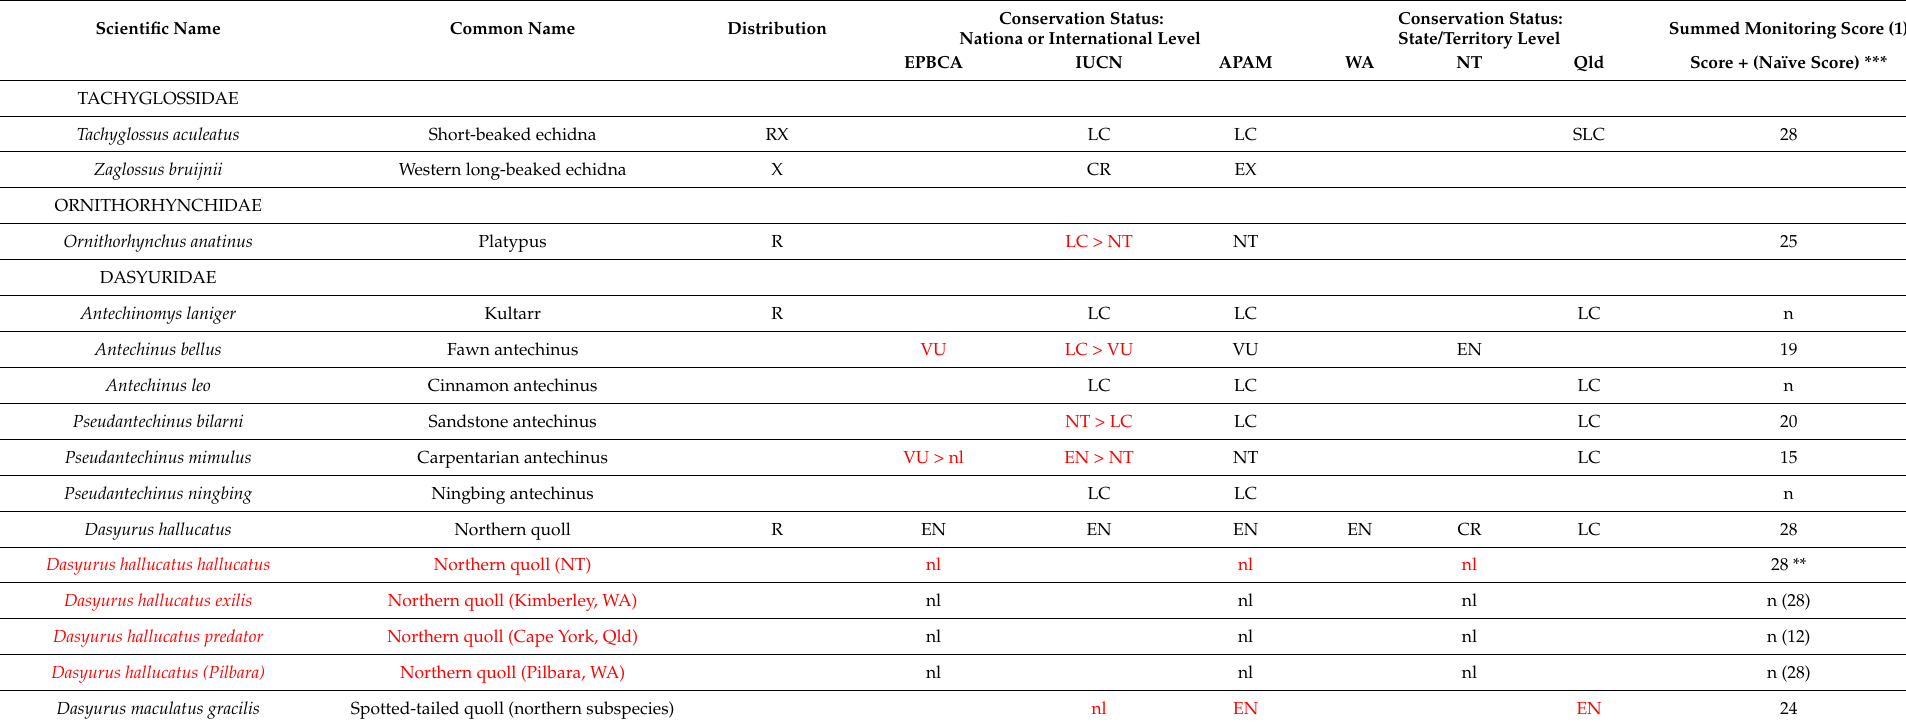
Table 1. List of mammal species occurring in northern Australia at the time of European settlement (updated from Ziembicki et al. 2015) [23]. Note that this excludes the Wet Tropics area of northeastern Australia. Distribution (at the time of European settlement) is in addition to northern Australia: R = other parts of Australia; X = extralimital. Conservation status is given as for Australian national legislation ( Environment Protection and Biodiversity Conservation Act 1999 ; EPBCA), the IUCN Red List, and as assessed in the Action Plan for Australian Mammals 2012 (APAM) [51]. Conservation status categories: EX: extinct, EXW: extinct in the wild, CR(PE): critically endangered (possibly extinct), CR: critically endangered, EN: endangered, VU: vulnerable, NT (CD): near threatened (conservation dependent), NT: near threatened, LC: least concern, and DD: data deficient. Note that EPBCA and APAM status refer to Australian range only. Changes since the original table are highlighted in red font, with an arrow (>) to indicate changes; nl = not listed; ‘n’ = not listed as monitored (Woinarski et al. 2018b) [19]; for conservation status at the state/territory level, WA refers to listing in the Western Australian Biodiversity Conservation Regulations 2018 , NT to listing in the Northern Territory’s Territory Parks and Wildlife Conservation Act 1976, and Qld to listing in Queensland’s Nature Conservation Act 1992 . (1) [19]—max score 45 based on 9 evaluation